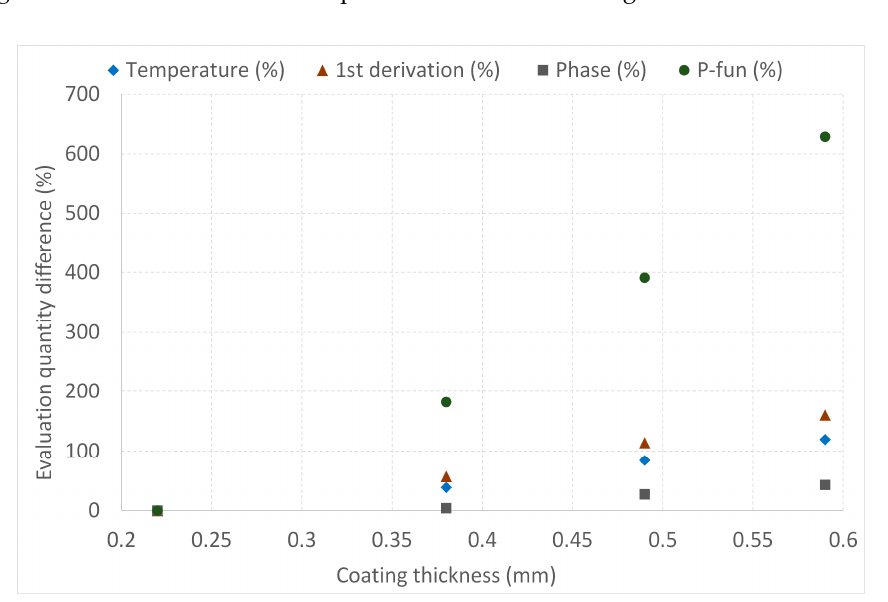
Figure 1. Dependence of IRNDT evaluation results obtained by different methods on coating